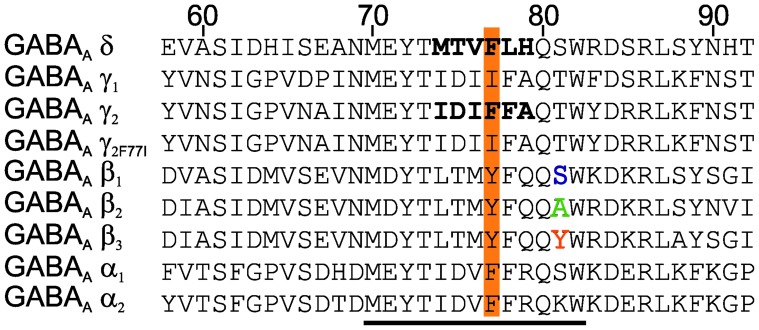
Sequence alignment of GABAA receptor subunits between amino acids 58 and 92 (γ2 mouse numbering).Underlined is a putative assembly signal conserved in different GABAA receptor subunits (36)). Note no difference between all three β- subunits in the putative assembly signal: MDYTLTMYFQQ_W with the exception for the position 81 (different residues are indicated in different colour). Interestingly, these coloured β subunit-specific residues were shown previously to affect stabilization of a homomeric assembly (45). Fat letters show δ: MTVFLH and γ2: IDIFFA motifs which were exchanged in the chimeric γ2(δ74–79) subunit. Orange field indicates location of γ2F77 site involved in zolpidem binding as well as homologous or same residues at other GABAAR subunits.